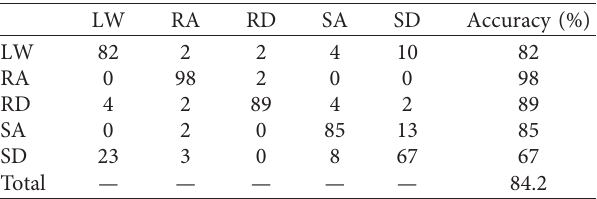
Figure 8: Transient-state recognition at prestance phase. Table 3: The confusion matrix of LightGBM classifier in preswing transient state.